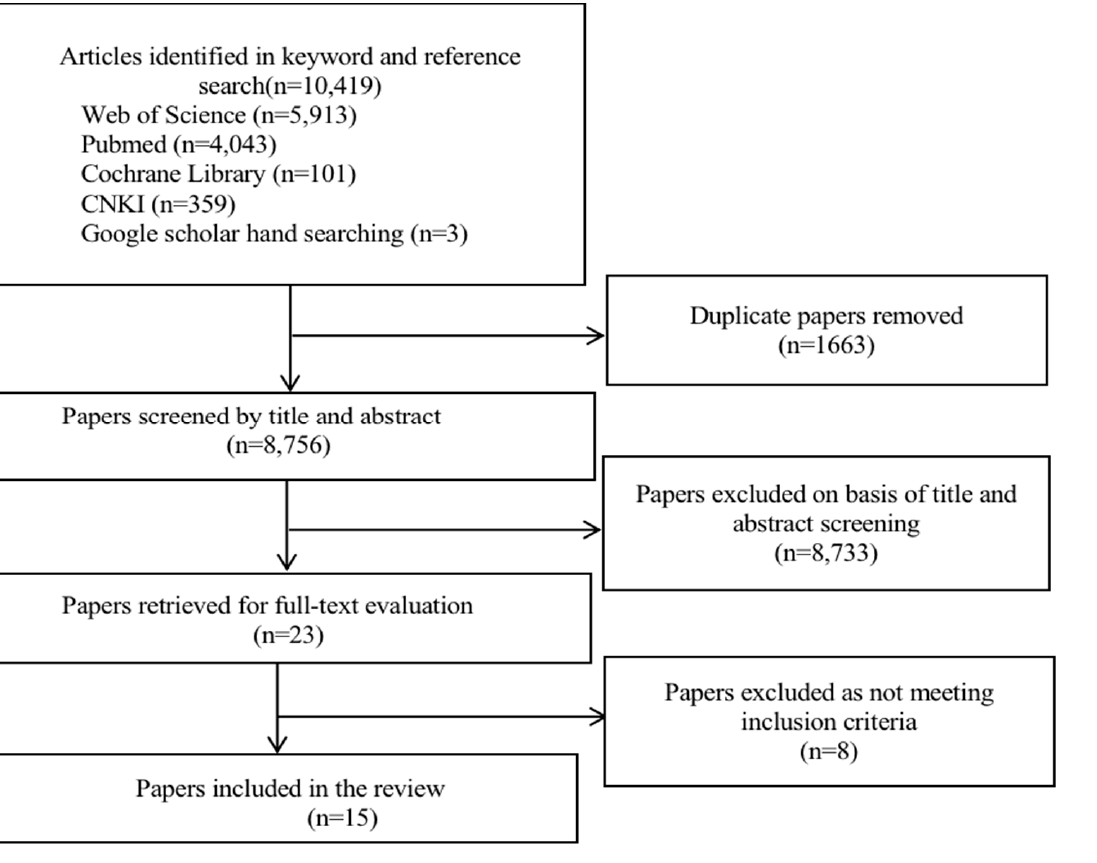
Figure 1. Study selection